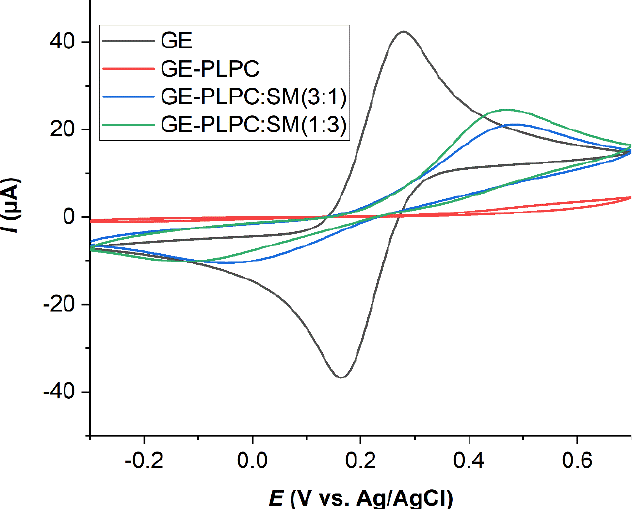
Figure 1. Cyclic voltammograms (CVs) of 10 mM K 4 [Fe(CN) 6 ] in 50 mM phosphate buffer solution (scan rate 50 mV ∙ s −1 ) for bare gold electrode (GE, black curve) and after formation of PLPC (PLPC, red curve), PLPC:SM (3:1, blue curve), and PLPC:SM (1:3, green curve) lipid bilayers, respectively